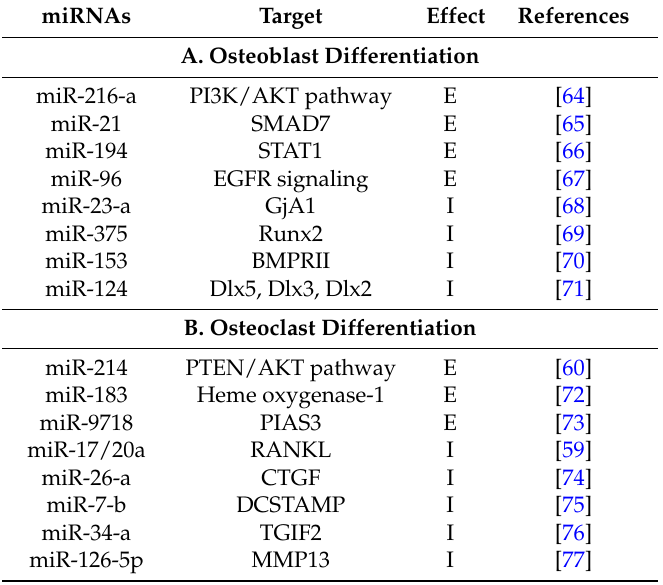
Table 3. Example of functional miRNAs in osteoblast (A) and osteoclast (B) differentiation. miRNAs Target